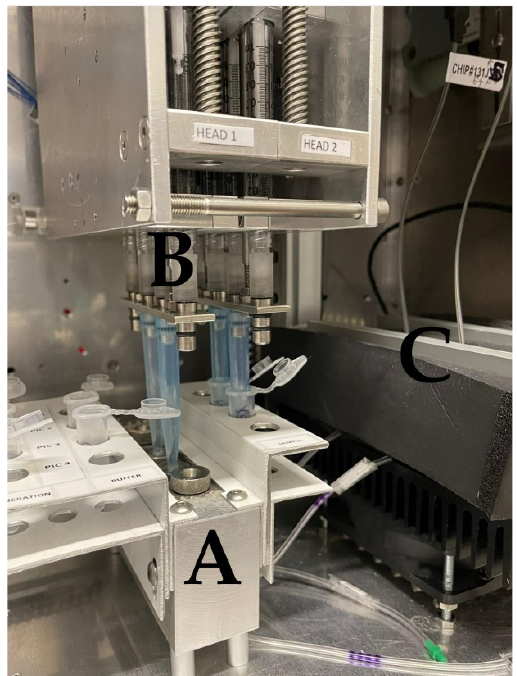
Figure 1. A—Sample and buffer holder. Pipette tips are pressed against the microfluidic inlet (circular button on the top area of the holder) to propel the fluids to the sensors. B—Syringe system that draws and propels fluids, C—Insulating material. Under it lie the sensors on a Peltier surface that keeps the temperature steady at 25 °C. The optic fibers (tagged cables) of the PICs exit the insulating material through holes.